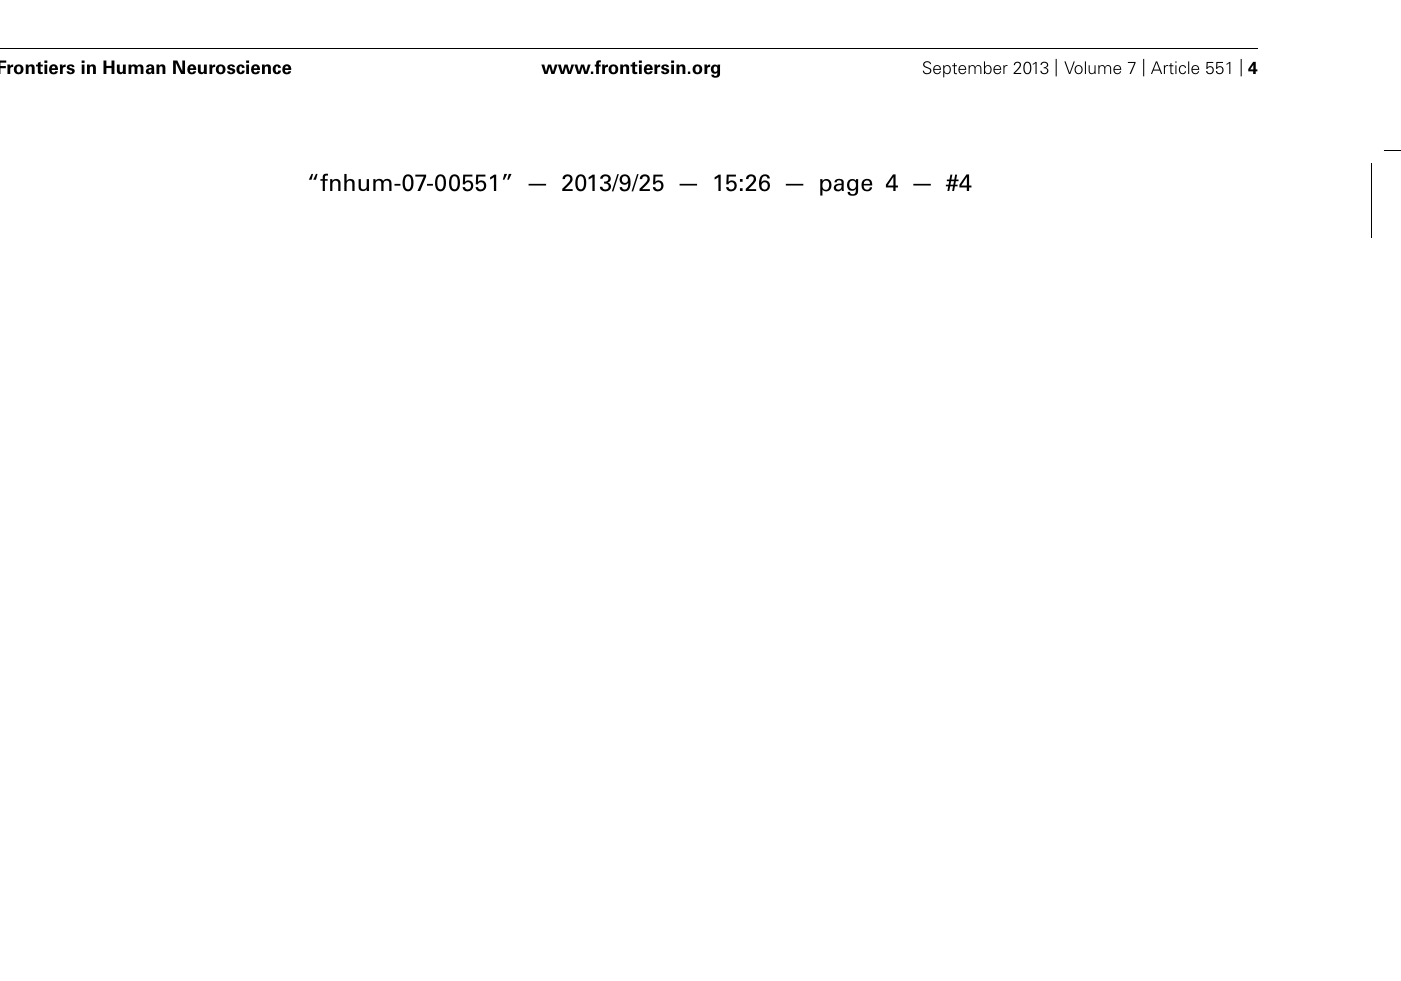
types of tasks: the Affect Grid task, the identification task, and